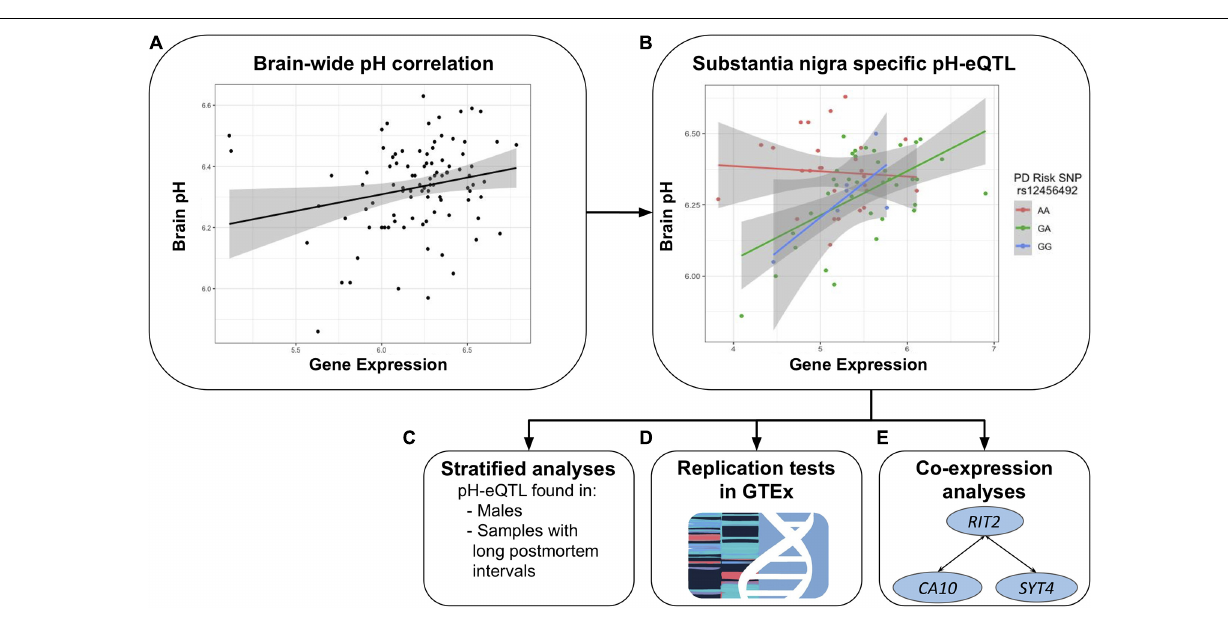
FIGURE 2 | Overview of the study. Focused on RIT2 and SYT4 , the relationship between pH and gene expression was tested brain-wide (A) . Region-specific tests revealed a pH-eQTL involving the PD risk polymorphism rs12456492 in the substantia nigra (B) . When the sample is stratified, this relationship is only observed within males and samples with longer post mortem intervals (C) . GTEx was used for replication tests (D) . Lastly, we performed a further analysis that identified co-expression between RIT2, SYT4, and CA10 (E) .